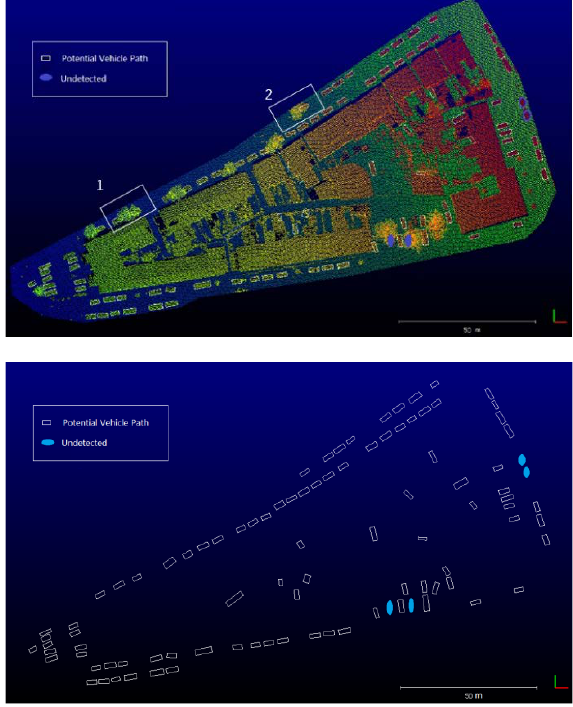
Fig. 7 The detected potential vehicle segments From Fig. 7, 92 potential vehicle segments are obtained, denoted by blank rectangles, where 13 vehicles are entirely or partially parked under trees. 14 of the segments are non-vehicles, and 4 vehicles are not detected (denoted by solid ellipses). under a tree. The vertical profile of the two areas is shown in Fig.